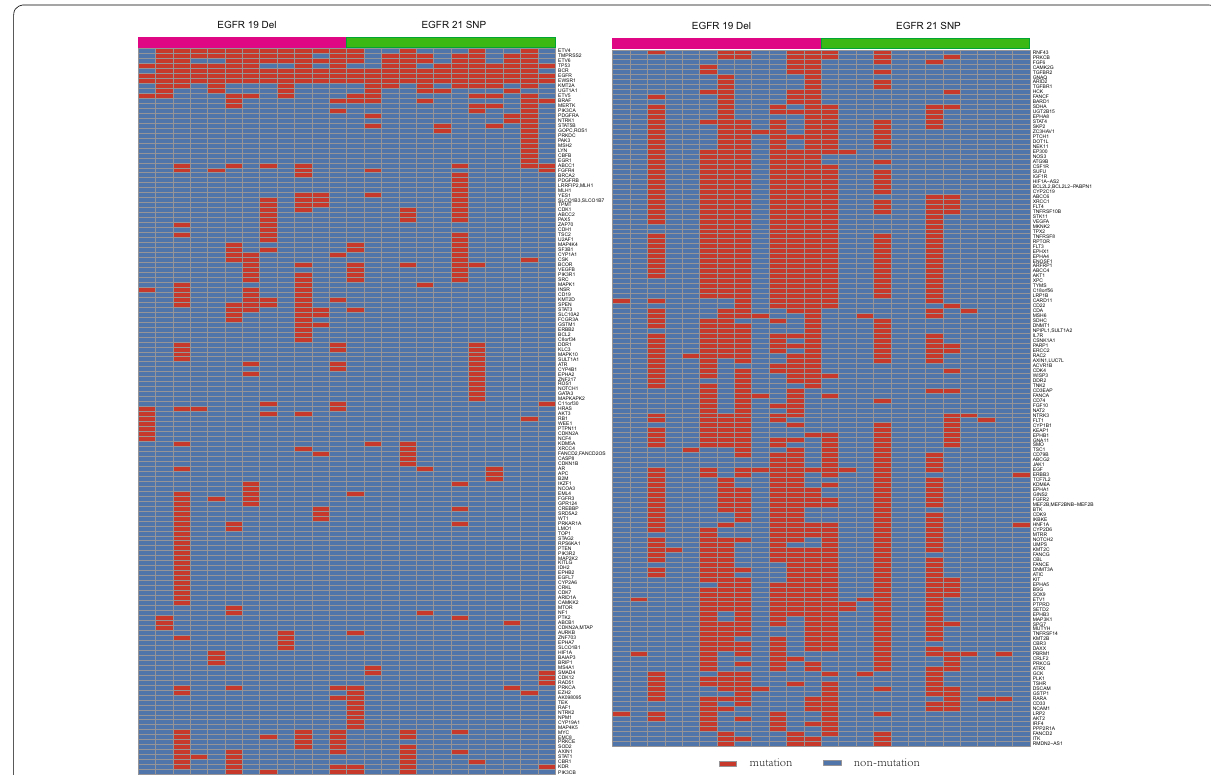
Fig. 3 Heat map of 483 cancer‑related genes in 12 pairs of patients with the EGFR 19 del or L858R mutation. The red squares represent genes with a mutation, and the blue squares represent those with no